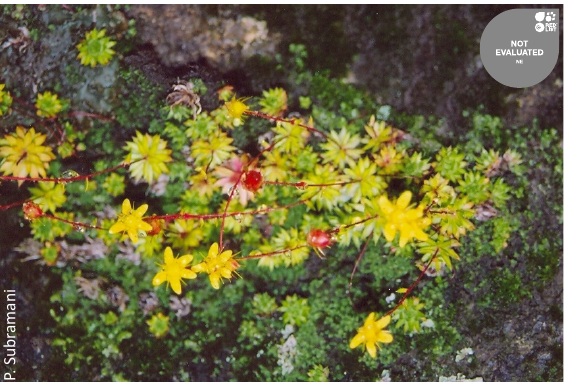
Image 55. Saxifraga brunonis Wall. ex